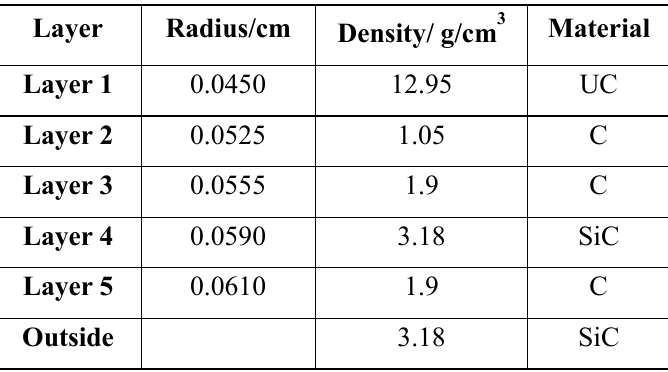
Table I. Dimension and components of TRISO